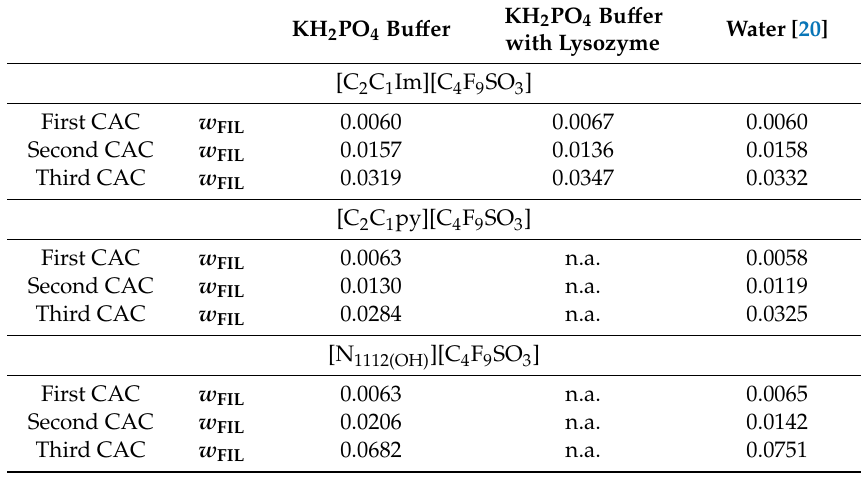
Table 2. Critical aggregation concentrations, CAC, determined by conductometry at 25 ◦ C